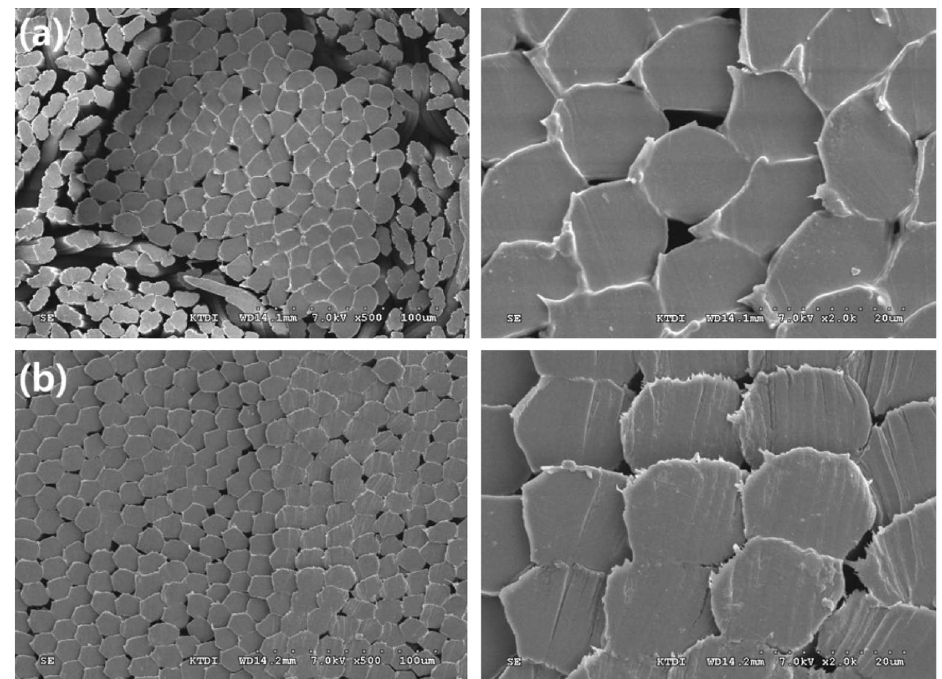
Figure 2. SEM images of para-aramid yarn: (a) 500 × and 2000 × magnification images of 200 denier para- aramid yarn used on the fabric surface and (b) 500 × and 2000 × magnification images of 400 denier para-aramid yarn used on the rear of the fabric.